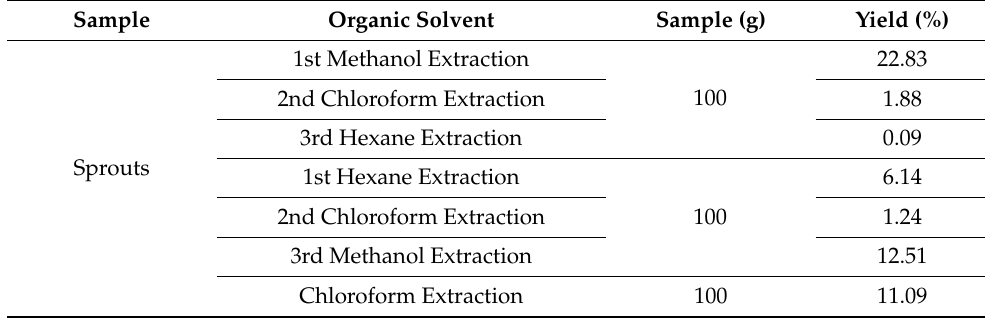
Table 1. Extraction yields from fenugreek sprouts and seeds using different solvents.